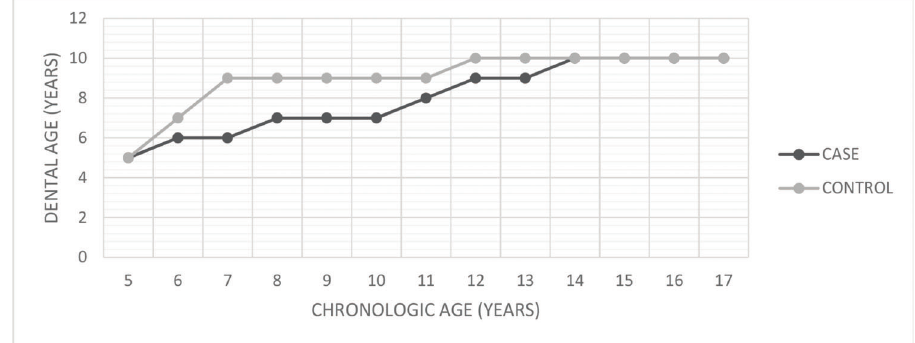
A-B: right maxilla; B-C: left maxilla; H-G: right mandibular ramus; D-E: left mandibular ramus; G-F: right mandibular body; E-F: left mandibular body; F-I: anterior mandibular alveolar ridge; HGF: right mandibular angle; DEF: left mandibular angle. * p o 0.05. The bold numbers are the statistical significant difference between case-study groups.